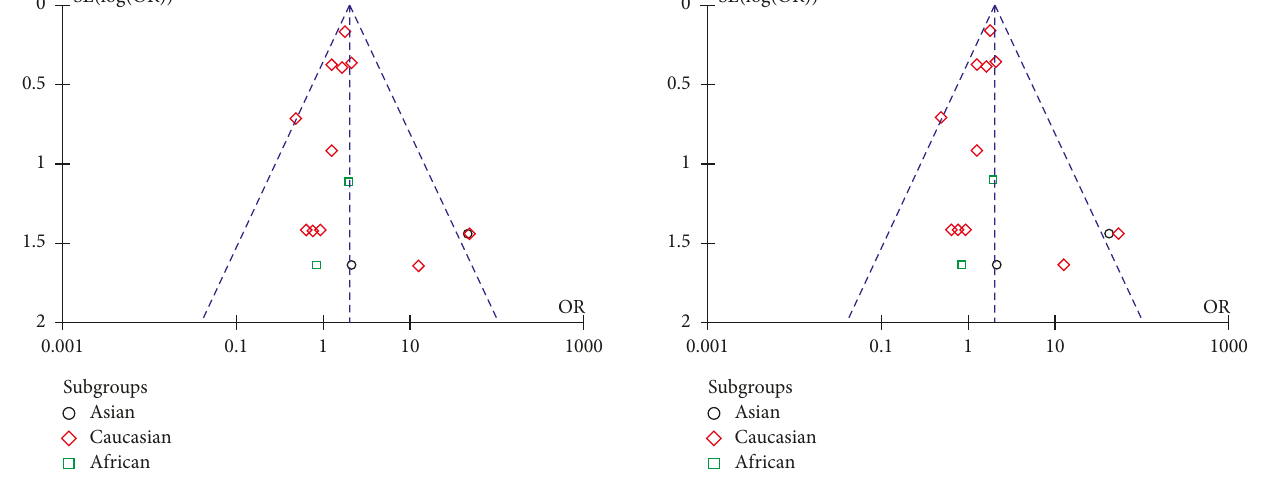
Figure 4: Funnel plot of genotype analysis for E326K in PD. Figure 5: Funnel plot of allele analysis for E326K in